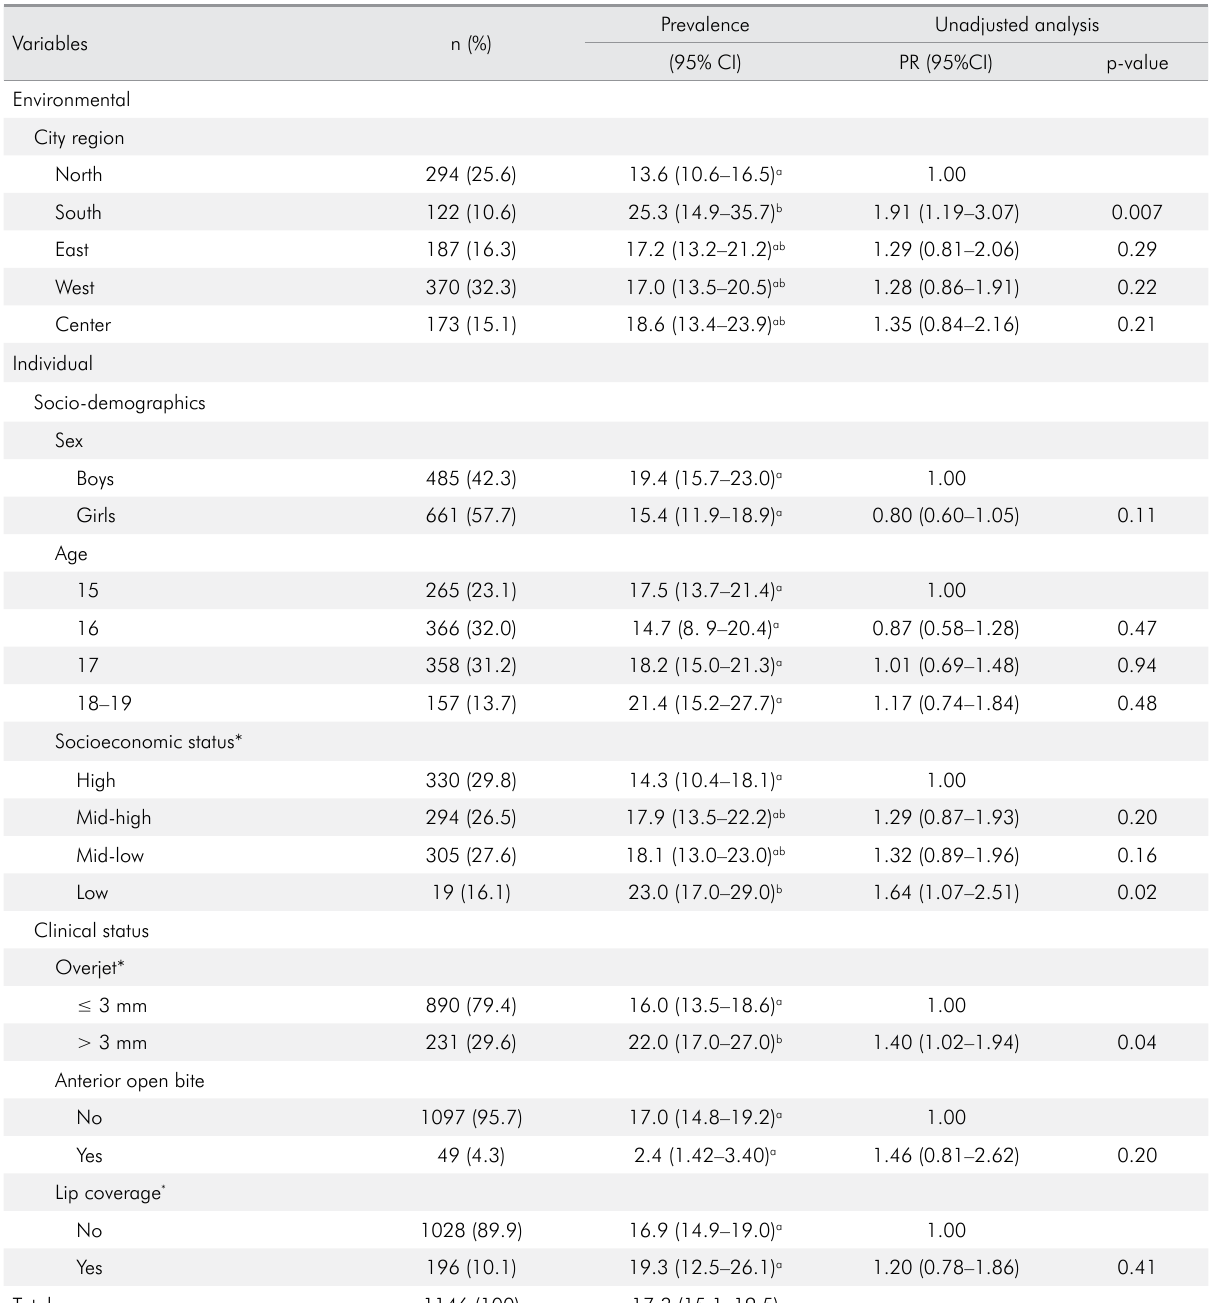
Table 1. Sample distribution, prevalence of TDI, and its unadjusted association with environmental and individual variables (multilevel Poisson